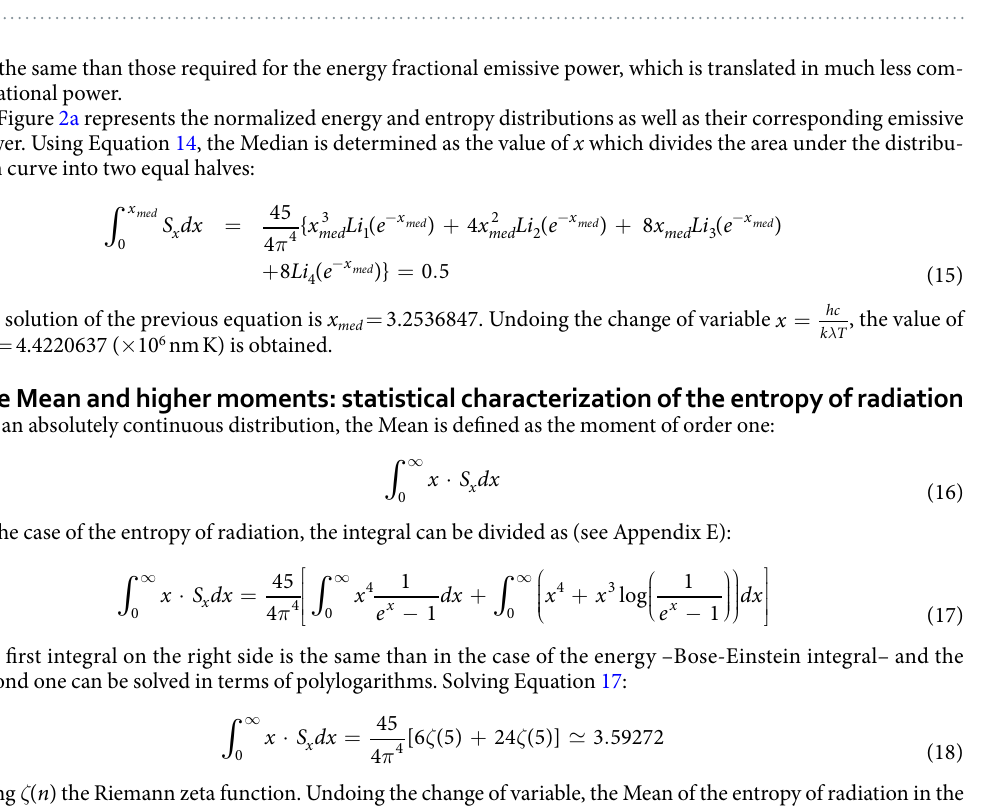
Figure 2. ( a ) (left): Normalized spectral energy and entropy distributions and their corresponding fractional emissive power. ( b ) (right): Zoom including central tendency values: Mode (energy  2.89777, entropy  3.00292), Mean (energy  3.75447, entropy  4.00477) and Median (energy  4.10731, entropy 